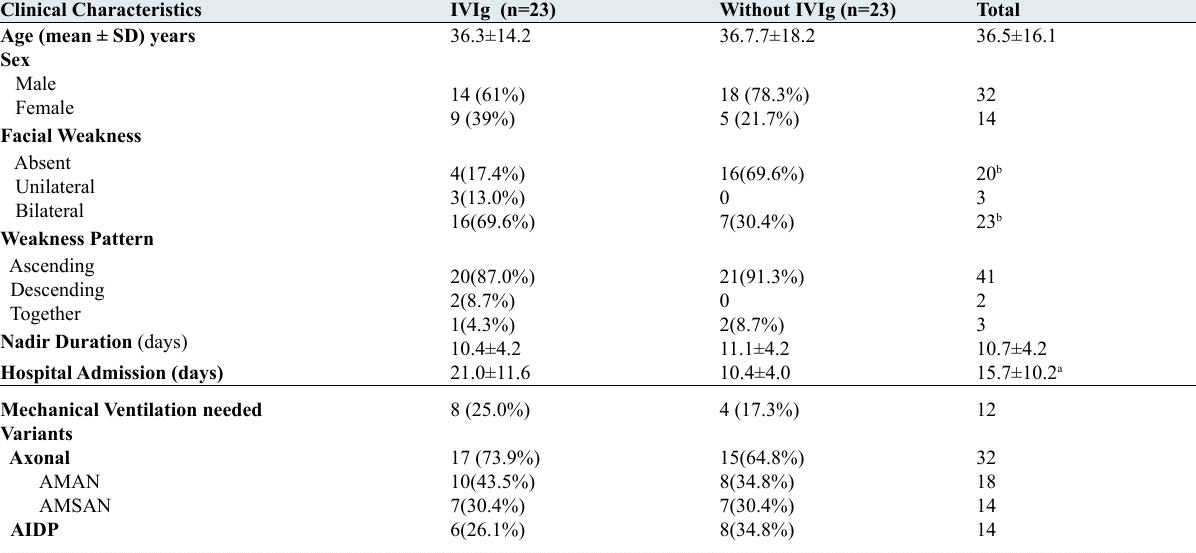
Table 1: Baseline demography of GBS patients Clinical